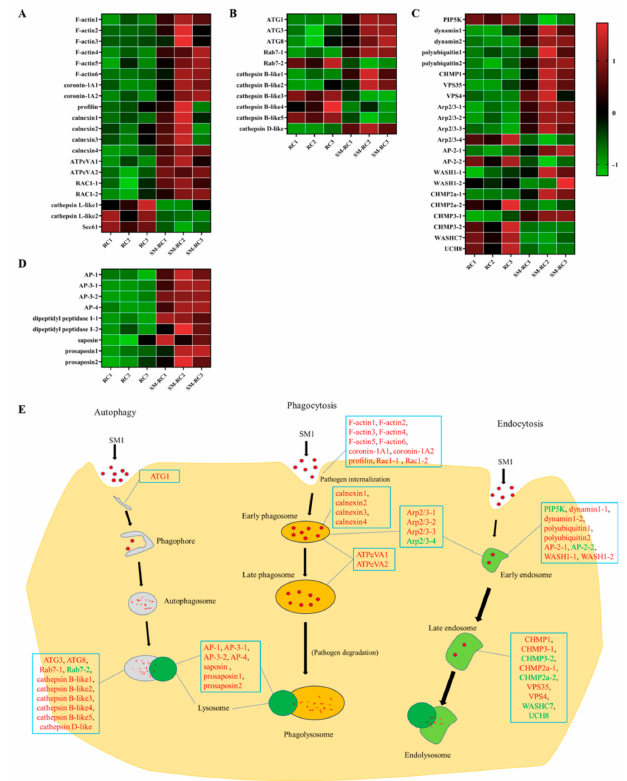
Figure 4. DEGs involved in the cellular response of R. chinensis infected by SM1. ( A ) Heatmap analysis of phagocytosis-related genes. ( B ) Heatmap analysis of autophagy-related genes. ( C ) Heatmap analysis of endocytosis-related genes. ( D ) Heatmap analysis of lysosome-related genes. ( E ) Schematic overview of a putative model of the cellular immune responses that occur in R. chinensis infected with SM1. RC1, RC2, and RC3: The control groups. SM-RC1, SM-RC2, and SM-RC3: R. chinensis infected with